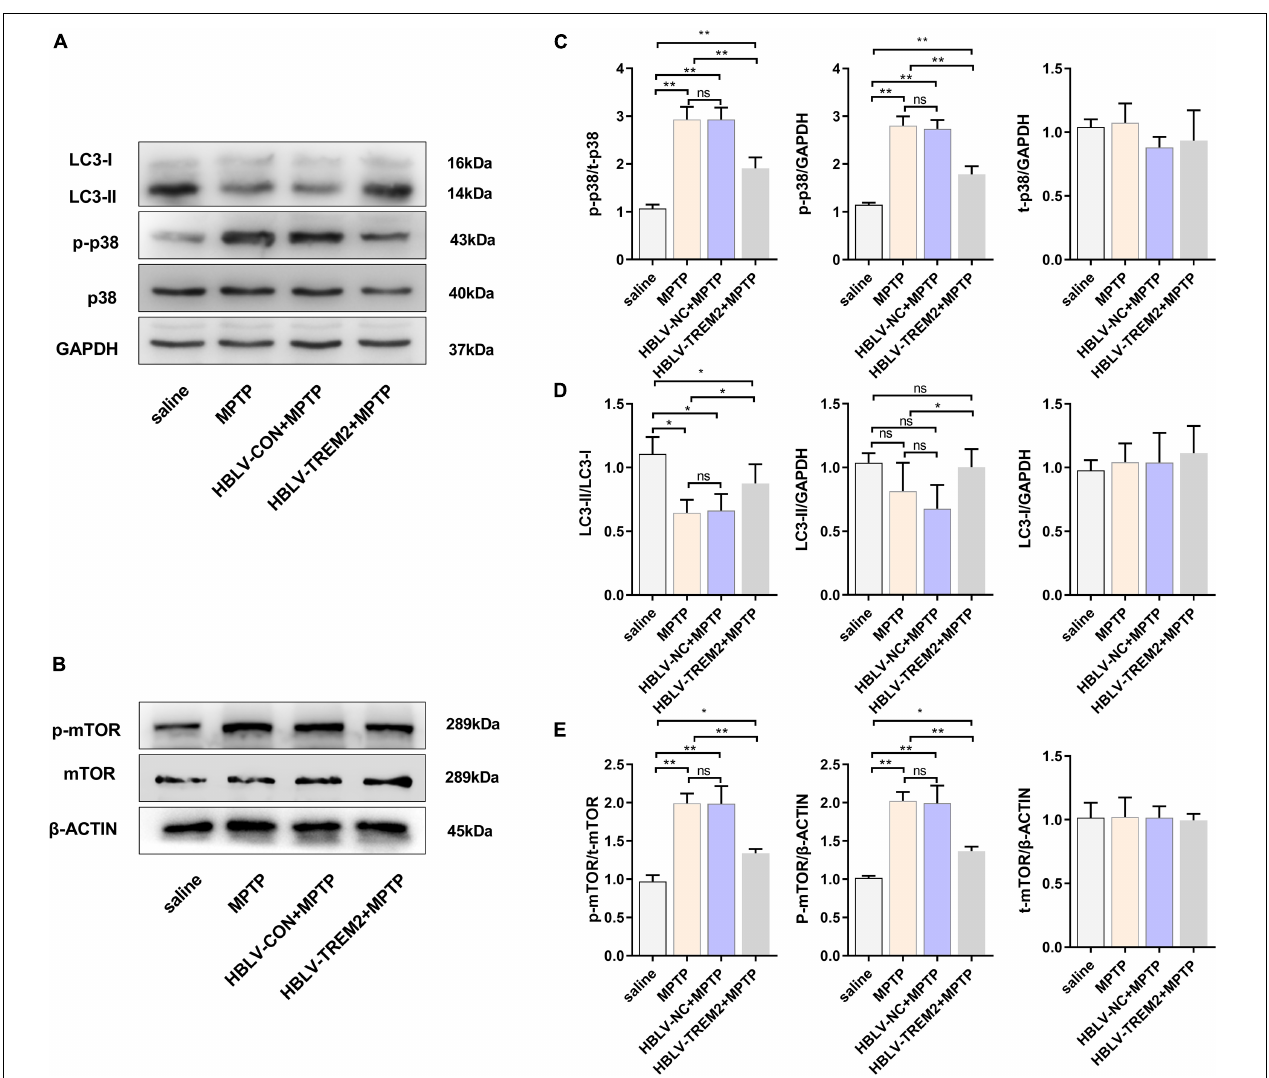
FIGURE 7 | Overexpression of TREM2 can inhibit the expression of p-p38, p-mTOR, and promote autophagy in SNpc of MPTP-treated mice. After the mice were injected with lentivirus and MPTP, the mice were decapitated, and the midbrain was obtained 7 days after the last MPTP injection. (A,B) The expression of TREM2, LC3, p-p38, p38, p-mTOR, mTOR were detected by WB ( n = 3/group). (C) The expression of p-p38 and p38 were analyzed by quantitative analysis of protein, the ratio of p-p38/p38 was shown ( F = 50.30). (D) The expression of LC3 was analyzed by quantitative analysis of protein, the ratio of LC3II/LC3I was shown ( F = 8.36). (E) The expression of p-mTOR and mTOR were analyzed by quantitative analysis of protein, the ratio of p-mTOR/mTOR was shown ( F = 38.15). All the quantitative analysis of protein was done by Image J to calculate the gray value. Data are shown as the mean ± SE. The fold change is significant where * P < 0.05, ** P < 0.01. n = number of